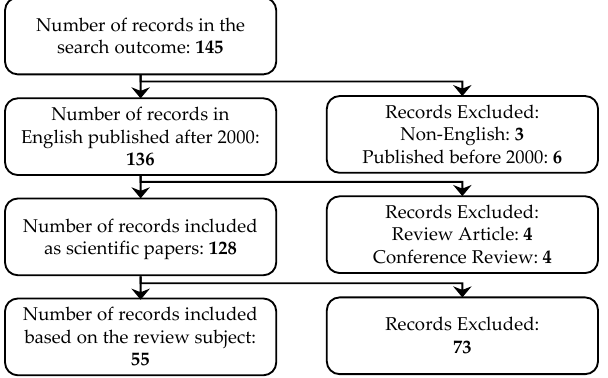
Figure 2. Process of screening the search results.